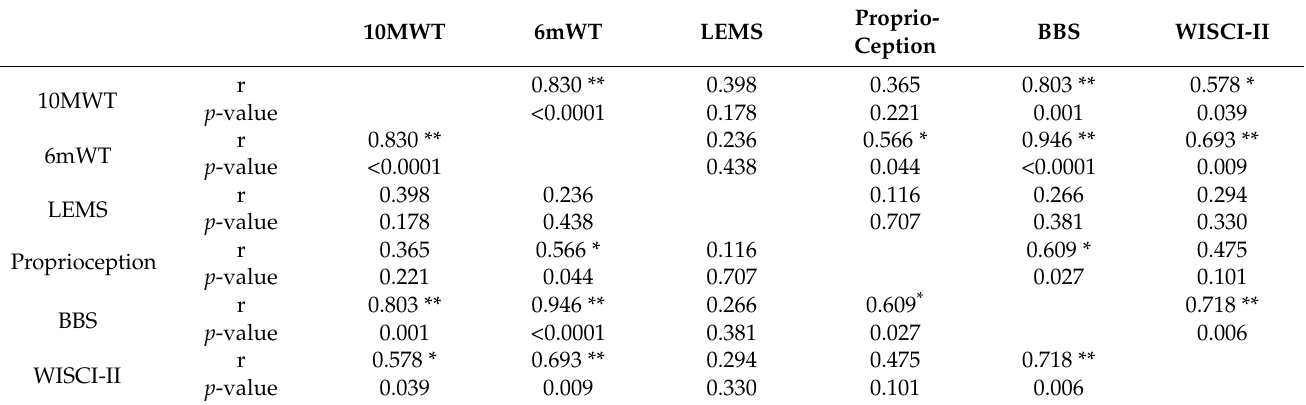
Table 6. Correlation between final clinical